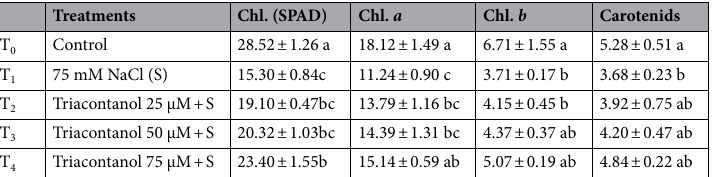
Table 3. Effects of triacontanol spray on photosynthetic pigments of Hot pepper plants under salt stress. Means sharing the same letter for a parameter, do not differ significantly at p ≤ 0.05; Chl = Chlorophyll.